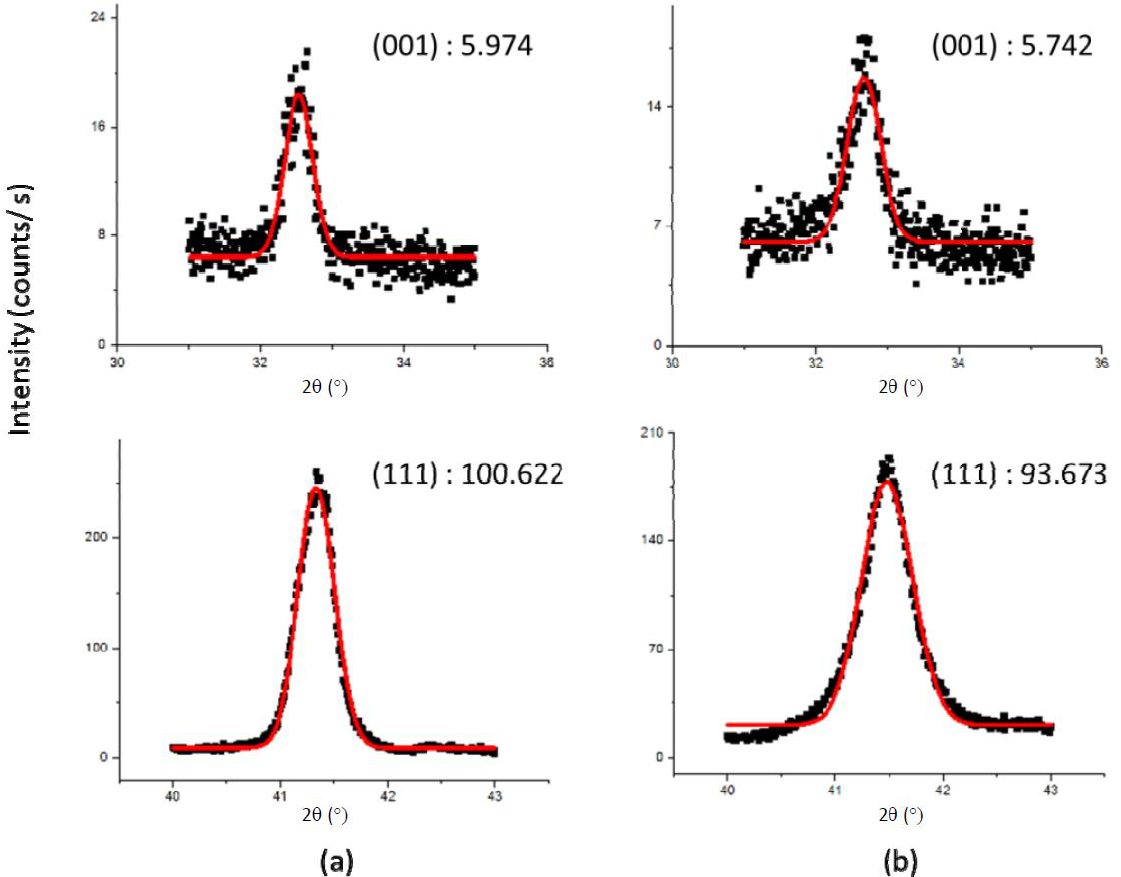
Figure 8. X-ray diffraction data and Gaussian fits of the (001) and (111) peaks for ( a ) unmilled and ( b ) 15 min milled samples. The numbers shown are areas (in arbitrary